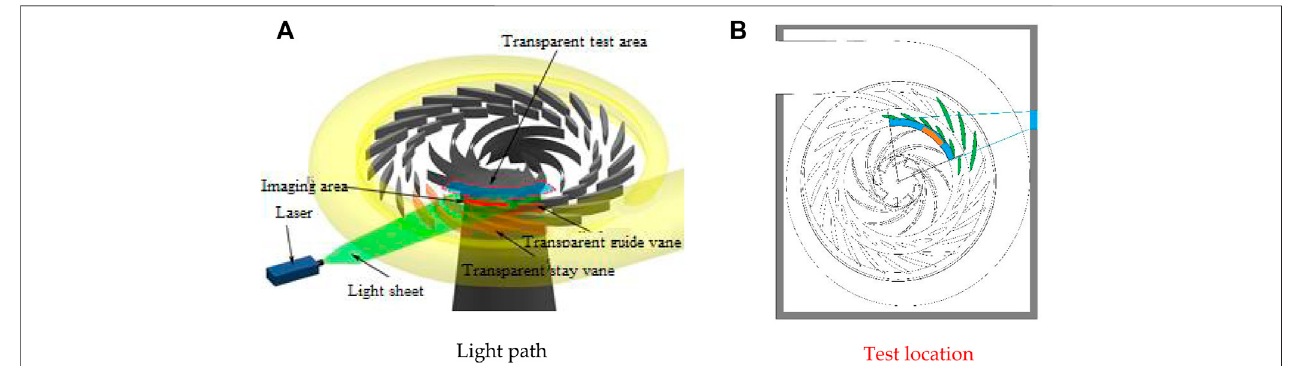
FIGURE 7 | Diagram of laser incident light path. (A) Polyamide resin (B) Silica.